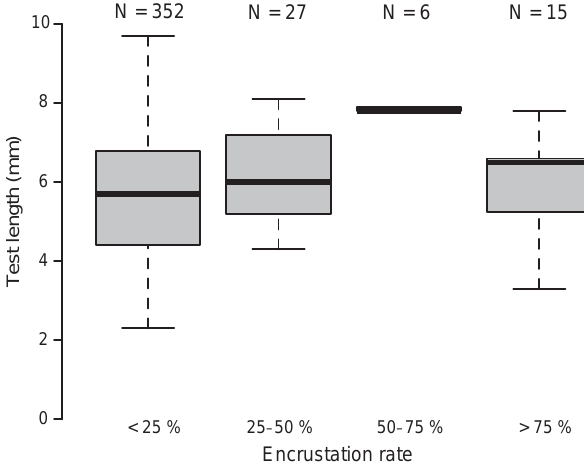
Fig. 5. Box-Whisker plot of the encrustation rates of Echinocyamus pusil- lus samples among the tests size. Outliers were removed from the graph. N, number of individuals.